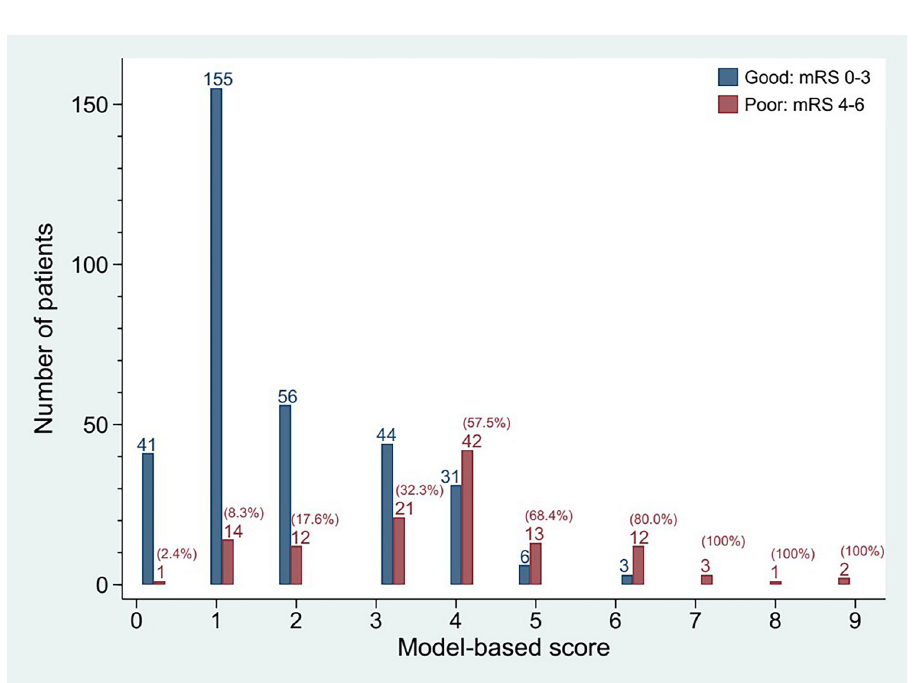
Fig 1. Distribution of patients with good and poor outcomes by model-based scores. Numbers in parenthesis representing the percentage of patients with poor outcomes; mRS, modified Rankin Scale.